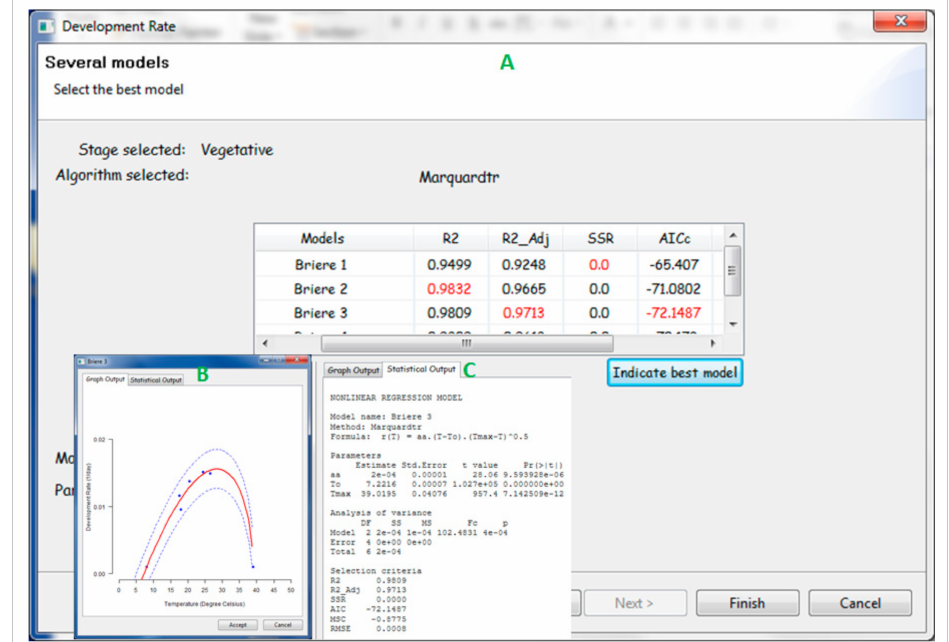
Figure 6. ( A ) Window of the PPMaP software presenting diverse models, each with corresponding model selection criteria for comparison; usually the best model has the smallest value of Akaike’s Information Criterion (AIC). ( B ) Example of points of data (blue) for a variety of maize at the vegetative phase fitted by Briere temperature-dependent mathematical expression (red curve). ( C ) The statistical criteria for model selection, the model parameters, and the (ANOVA) analysis of variances are shown.